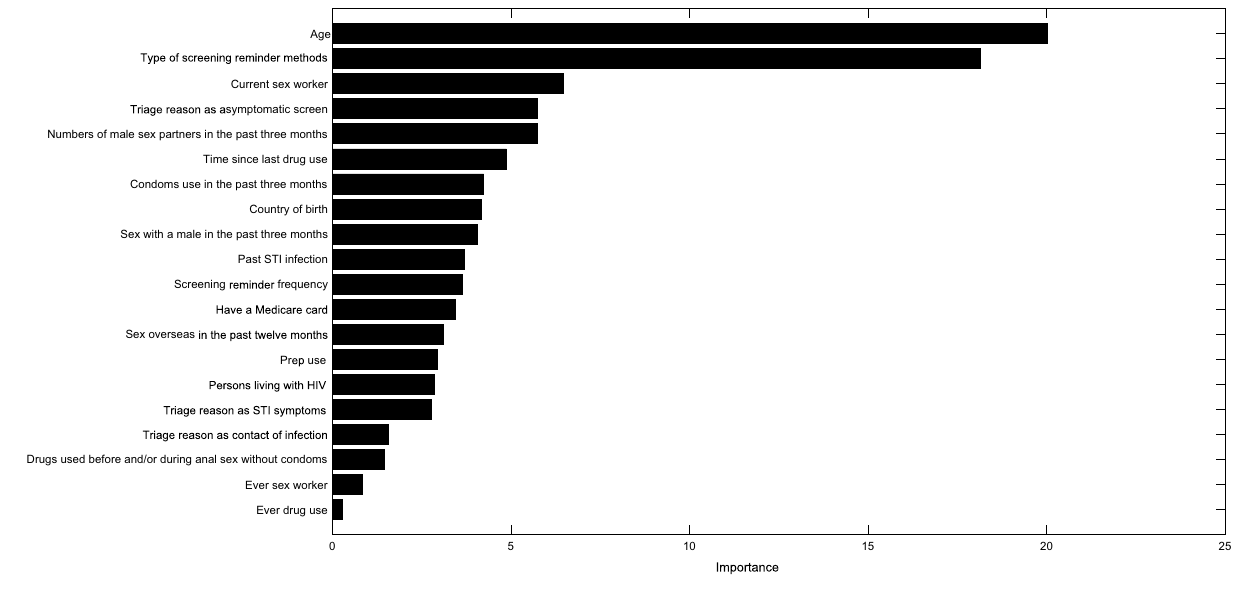
Figure 2. Variable importance in the prediction of timely clinic attendance after receiving a clinic reminder message by XGBoost.